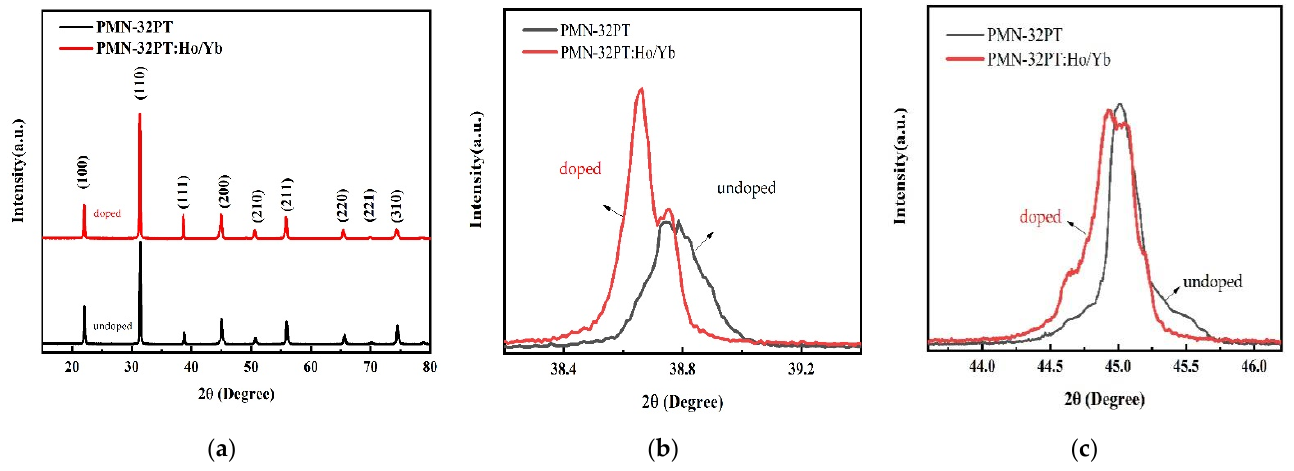
Figure 2. (a) XRD patterns from 10° to 80° of PMN-32PT:Ho 3+ /Yb 3+ and PMN-PT crystal powders ( b ) Figure 2. ( a ) XRD patterns from 10 ◦ to 80 ◦ of PMN-32PT:Ho 3+ /Yb 3+ and PMN-PT crystal powders enlarged XRD patterns from 38.2° to 39.5° ( c ) enlarged XRD patterns from 43.2° to 46.2°. ( b ) enlarged XRD patterns from 38.2 ◦ to 39.5 ◦ ( c ) enlarged XRD patterns from 43.2 ◦ to 46.2 ◦ .